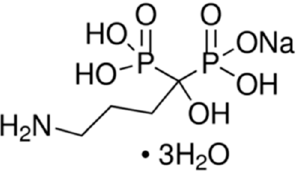
Figure 1. Chemical structure of alendronate sodium trihydrate (ALN).